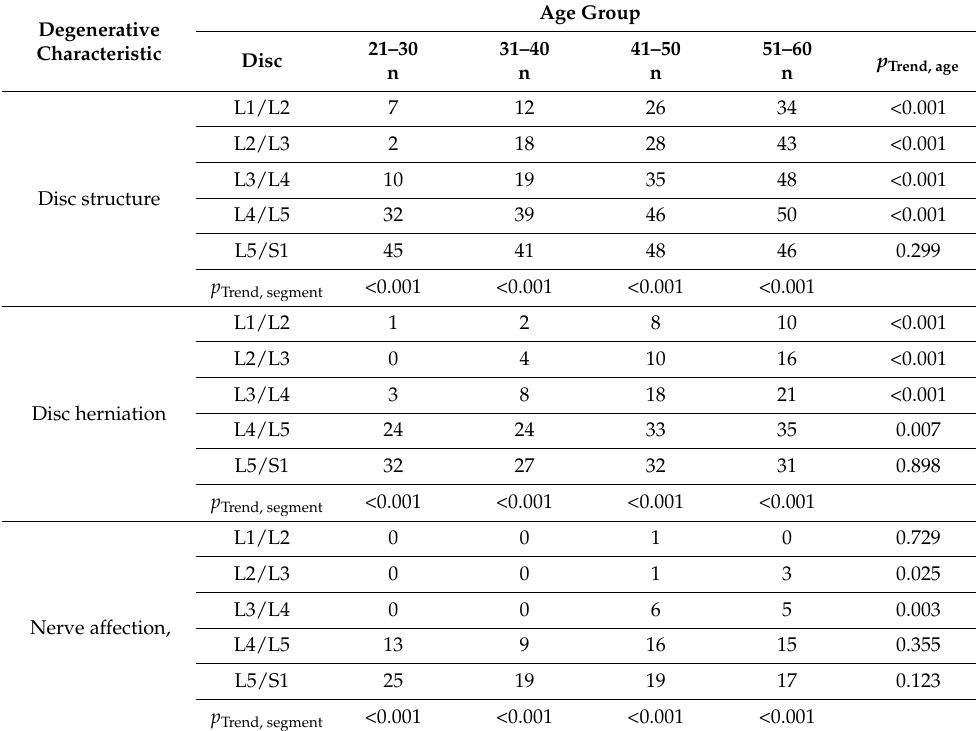
Table 6. Number of individual degenerative characteristics by age group and segment (maximum number n =